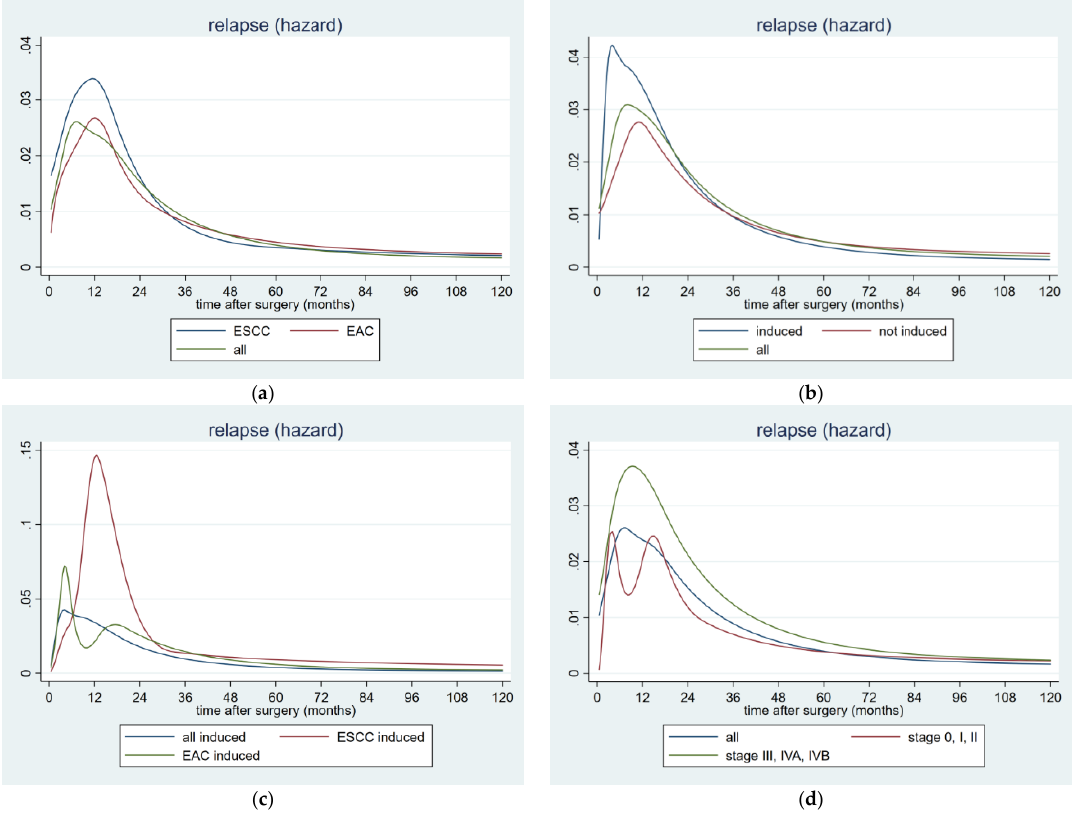
Figure 2. Hazard rate for postoperative tumor recurrence over time in 362 patients with resected esophageal cancer stratified by ( a ) histology and ( b ) induction treatment. ( c ) Hazard rate for postoperative tumor recurrence over time in 119 patients with resected esophageal cancer and induction therapy stratified by histology. ( d ) Hazard rate for postoperative tumor recurrence over time in 362 patients with resected esophageal cancer stratified by early and advanced tumor stage.